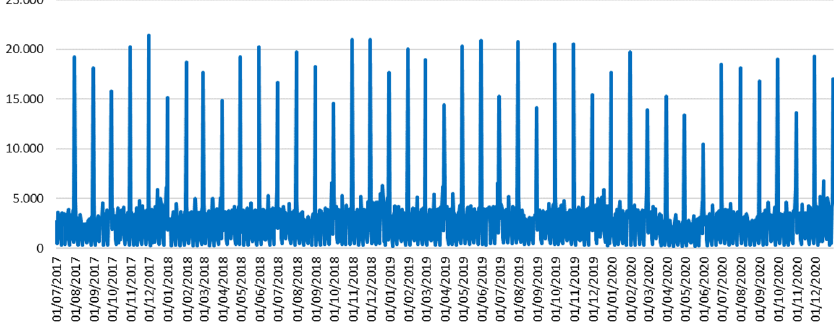
Fig. 1 Daily sales from SII (million e